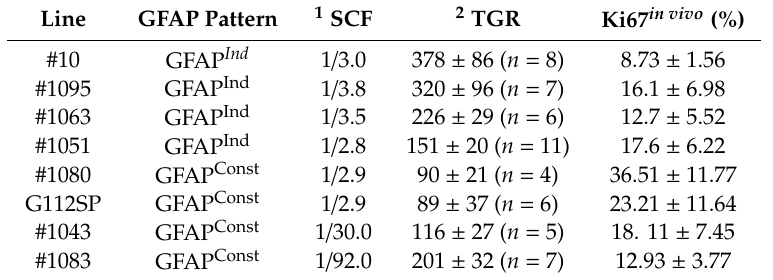
Table 1. Lack of correlation between self-renewal and tumor-propagating capacity in human GSCs. Line GFAP Pattern 1 SCF GFAP